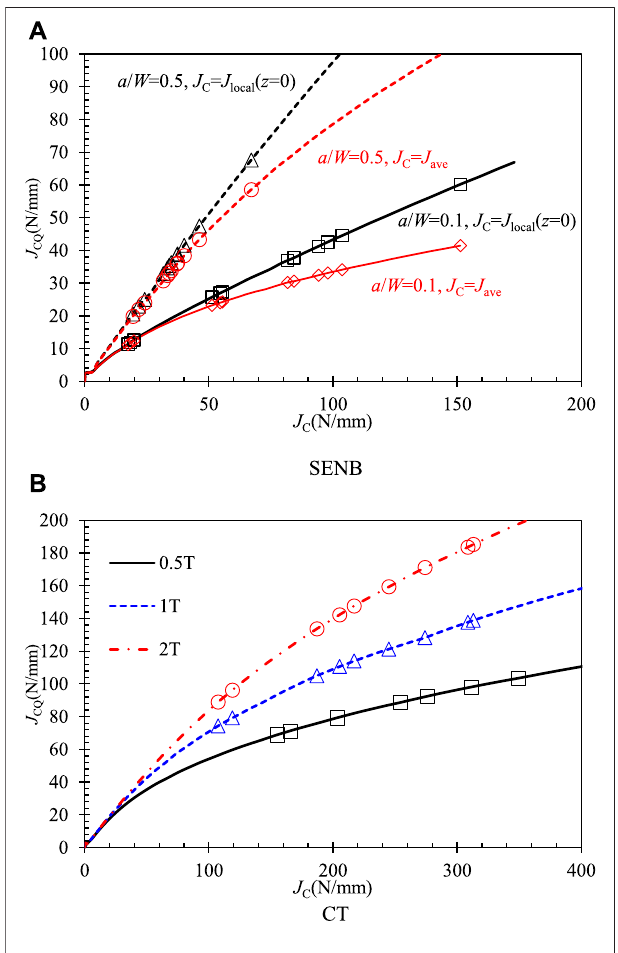
FIGURE 9 | Corrected fracture toughness to J CQ with Q (cid:1) 0 from the tested values of specimens based on the global approach. (A) SENB. (B) CT.